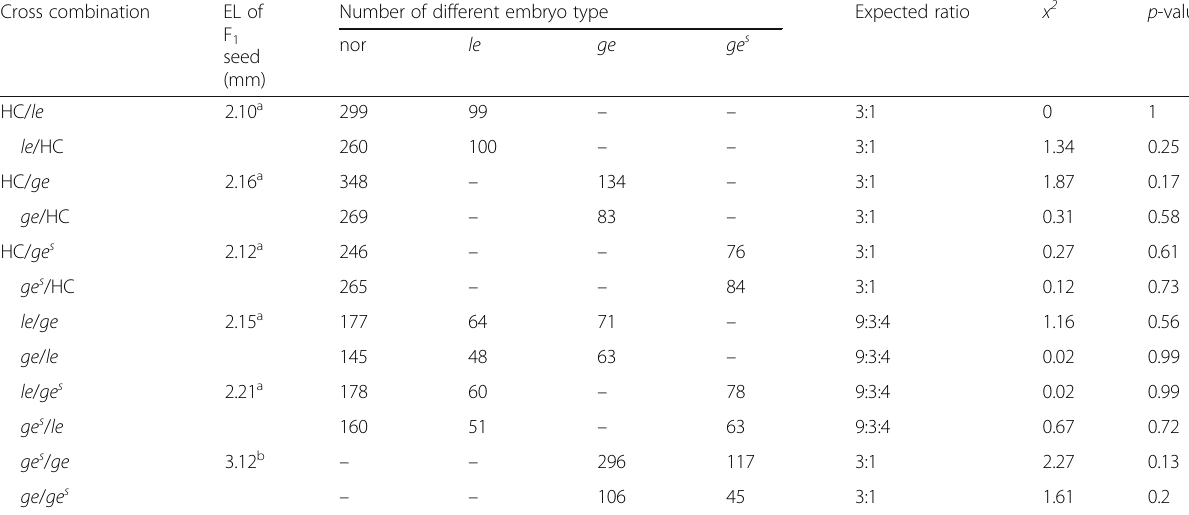
Table 1 Segregation of F 2 seeds derived from the reciprocal crosses among HC and three giant embryo mutants Cross combination EL of F 1 seed